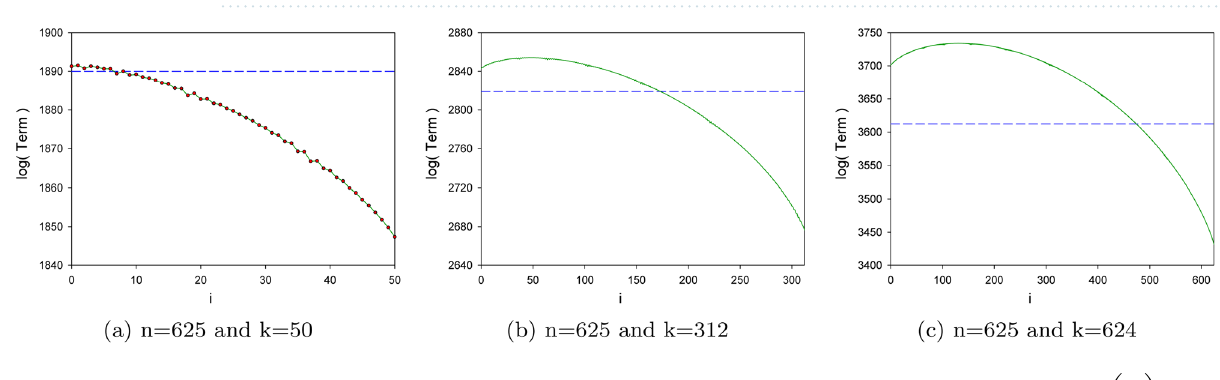
most of the time. This is reflected in a near perfect ···++−−++−−··· 1 , as shown in the left panel ( a ). To study the growth of coefficients − b i . | | Ŵ( i / 2 ) (cid:31) (cid:30)